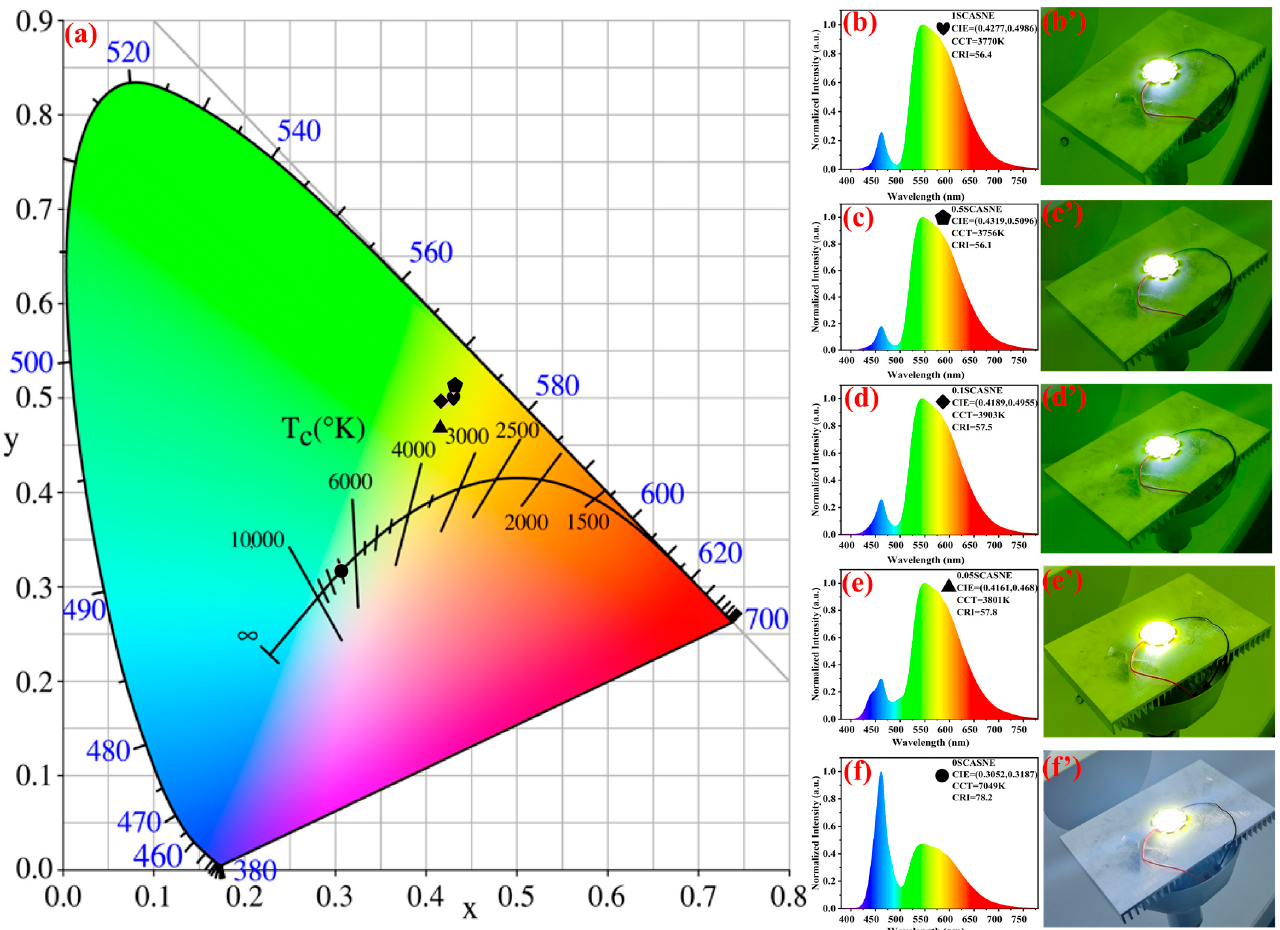
Figure 7. Chromaticity parameters, electroluminescence (EL) spectra, and corresponding photo- graphs of white LEDs driven by a 350 mA current: ( a ) the color coordinates, ( b / b’ ) 1SCASNE, ( c / c’ ) 0.5SCASNE, ( d / d’ ) 0.1SCASNE, ( e / e’ ) 0.05SCASNE, and ( f / f’ ) 0SCASNE. Heart, pentagon, diamond, triangle and circle represent the color coordinates of 1SCASNE, 0.5SCASNE, 0.1SCASNE, 0.05SCASNE, 0SCASNE, respectively.